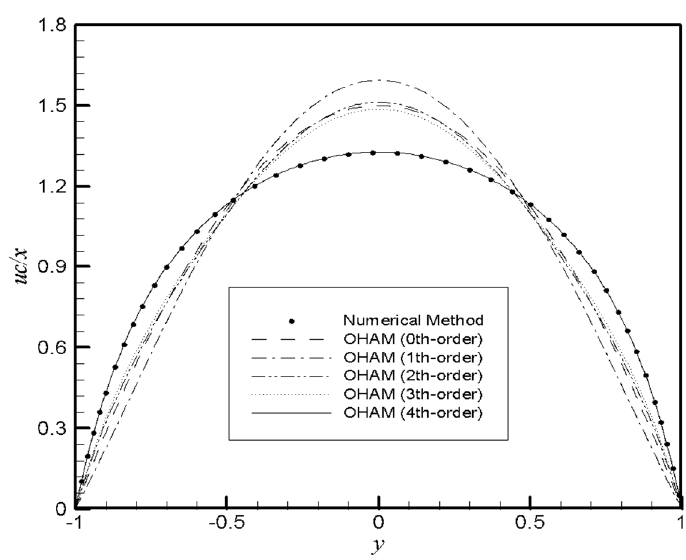
Figure 1. The analytical results for uc / x obtained by the OHAM at different orders of approximation compared with the numerical results Re = 5 and α = − 1.